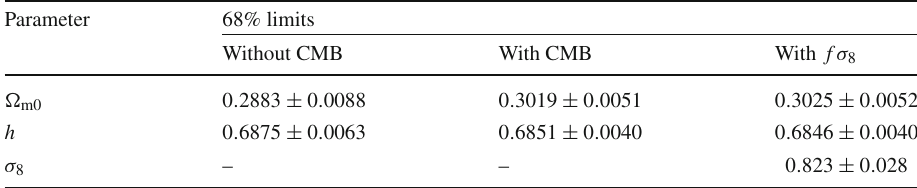
Table 4 The best fit values of free parameters and 1 σ uncertainties using different data sets for PEDE model in non-flat universe